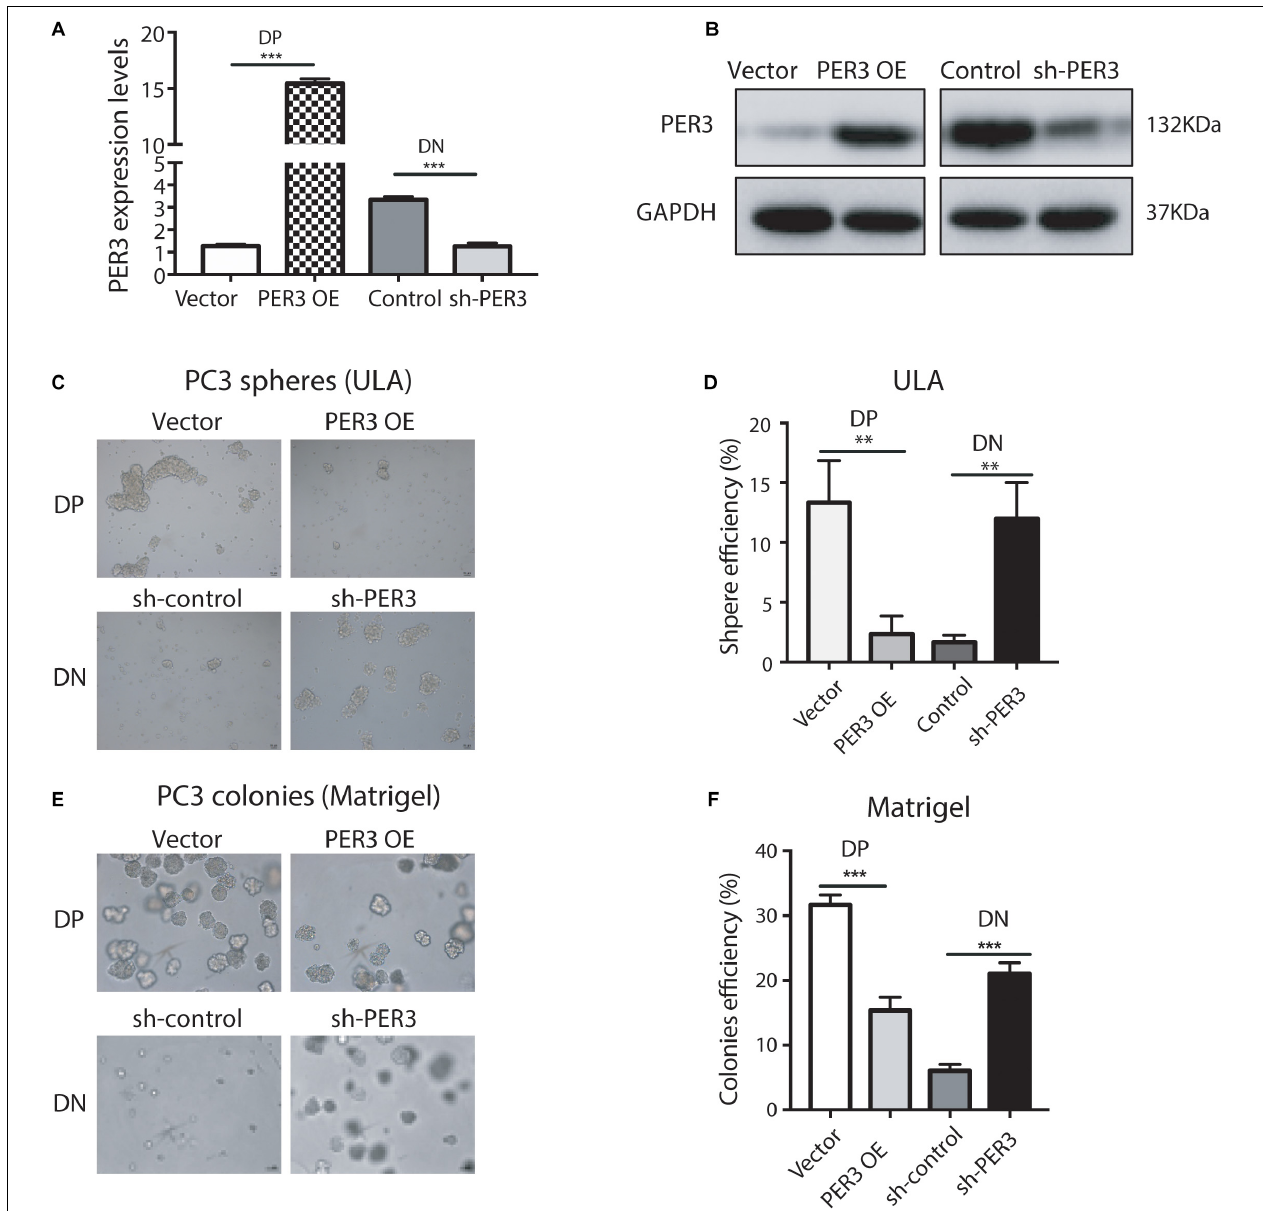
FIGURE 3 | PER3 regulates stemness of PC3 DP cells in vitro . (A) RT-qPCR analysis was used to evaluate efficiency of PER3 overexpression (OE) and knockdown (KD, or sh-PER3) in PC3 DP and PC3 DN cells, respectively. (B) Western blotting was performed to examine PER3 levels of PER3 OE in PC3 DP cells and PER3 KD in PC3 DN cells, respectively. (C,D) In sphere formation assays, PER3 OE in PC3 cells impairs their sphere-forming abilities whereas PER3 KD in PC3 DN cells improved their sphere formation. A total of 1,000 cells for each well were seeded in ULA plates. Spheres were imaged (C) and counted (D) for sphere efficiency 1–2 weeks later. (E,F) In colony formation assays, PER3 OE in PC3 DP cells abrogates their colony-forming abilities whereas PER3 KD in PC3 DN cells improved their clonogenicity. A total of 1,000 cells for each well were mixed with Matrigel and plated in 24-well culture plates. Colonies were imaged (E) and counted (F) for colonies efficiency 1–2 weeks later. Data are presented from three independent experiments. Scale bars, 100 µ m. ** P < 0.01, *** P <